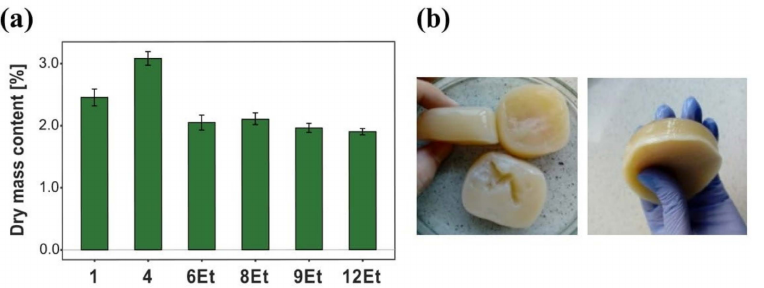
Figure 3. ( a ) Dry mass content in bacterial cellulose membranes synthesized by chosen strains, ( b ) more loose, gelatinous BNC synthesized by the 6th strain ( K. hansenii H3).